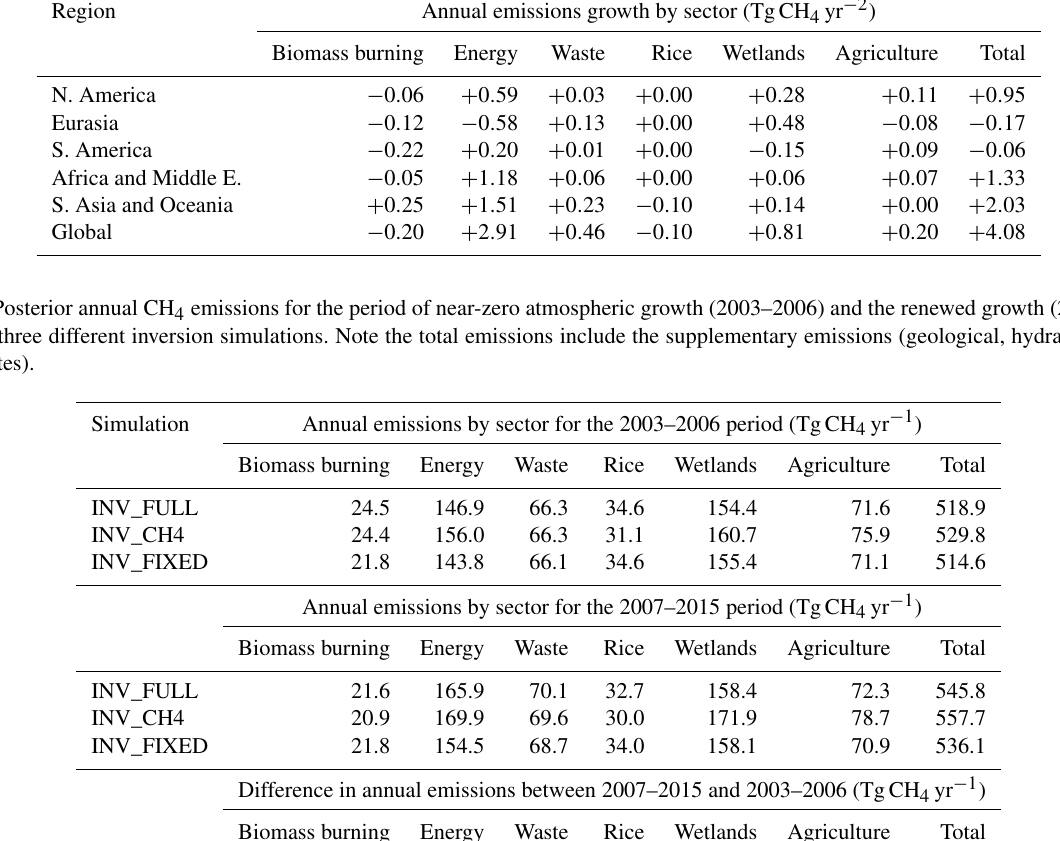
Table 5. Regional CH 4 emissions growth trends based on synthesis inversion estimates between 2003 and 2015. Region